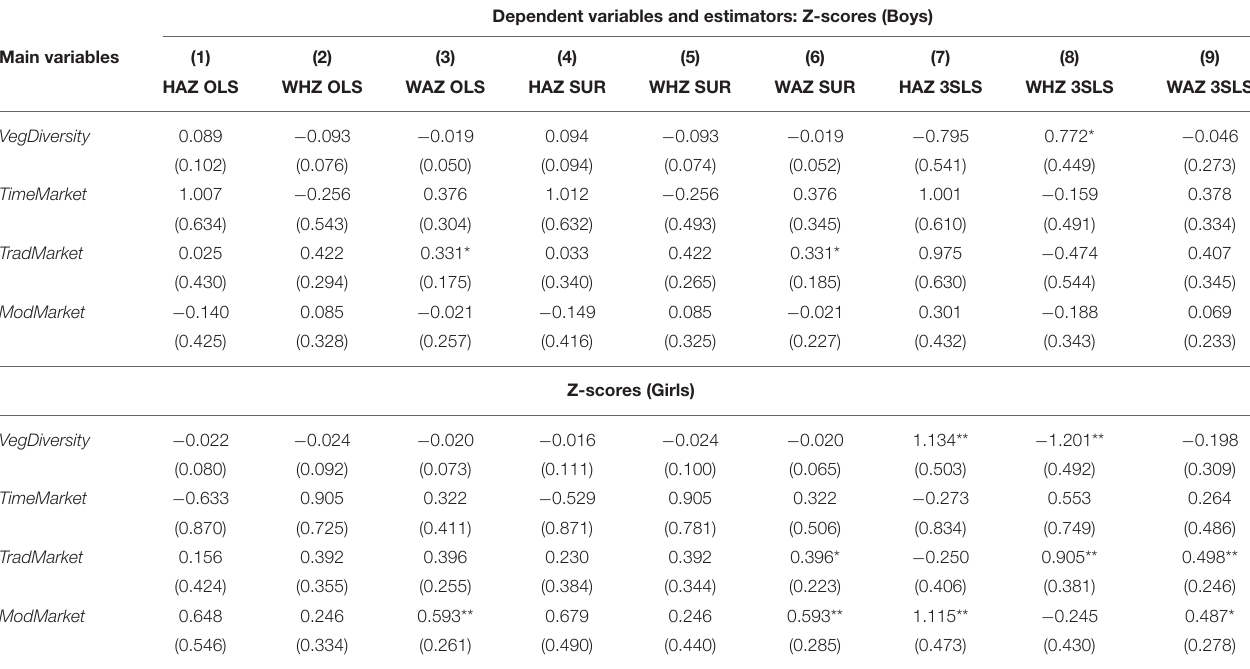
TABLE 3 | Impact of smallholder vegetable production on HAZ, WHZ, and WAZ of sampled boys and girls. Dependent variables and estimators: Z-scores